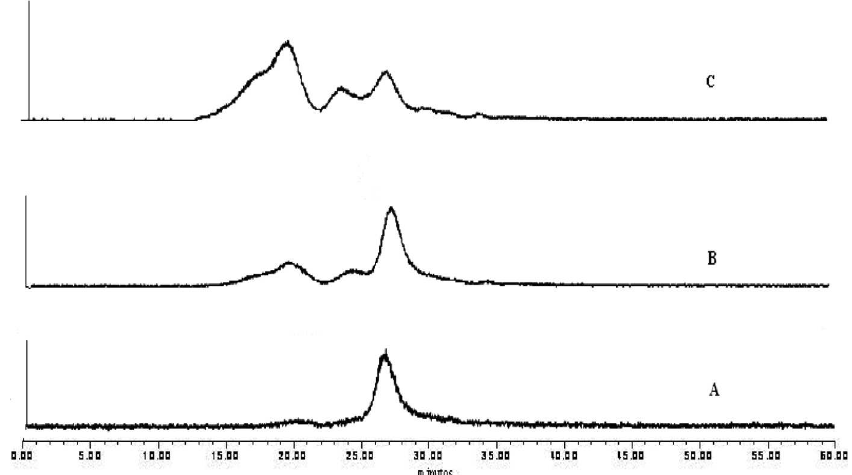
Figure 4 - Size exclusion HPLC radiochromatogram profile of: (A) 99m Tc-MAG3-cMORF; (B) SA:B-MORF:B- b Ala-BBN (1:1:3) + 99mTc- MAG3-cMORF; (C) SA:B-MORF:B- b Ala-BBN (1:1:2) + 99m